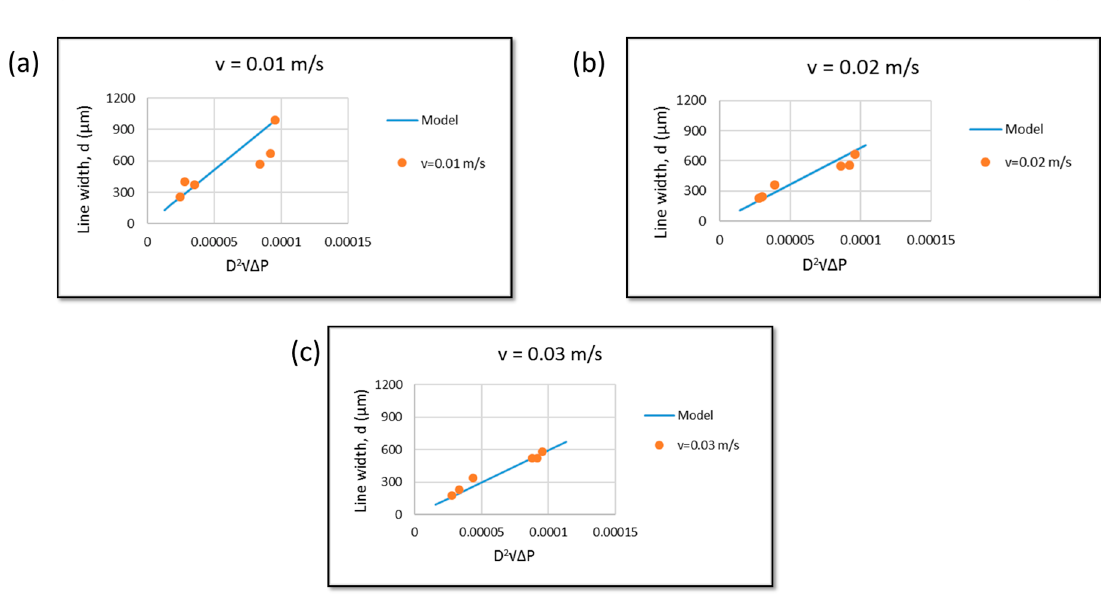
Figure 4. Relationship of d vs. D 2 √ ∆ P of experimental data and theoretical data at different condition : ( a ) v(cid:4662) = 0 . 01 m/s; ( b ) v(cid:4662) = 0 . 02 m/s and ( c ) v(cid:4662) = 0 . 03 m/s.